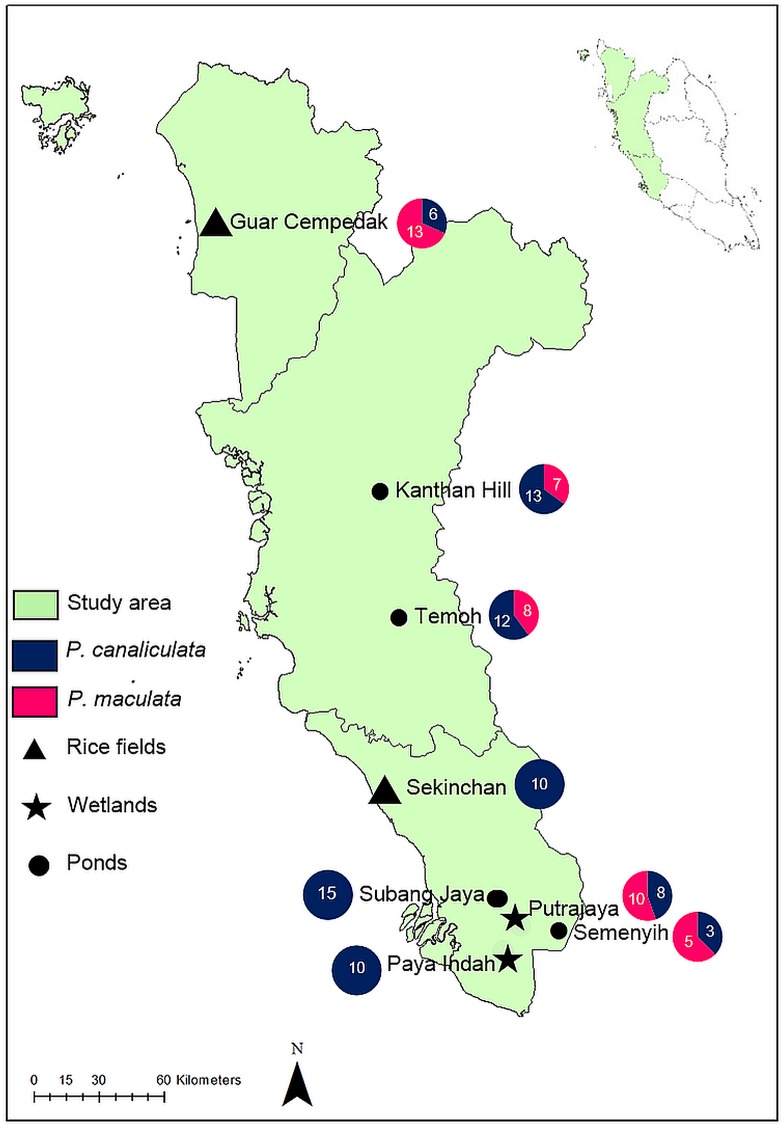
Geographic locations in Peninsular Malaysia where Pomacea specimens were collected February 2016—November 2016.Three to five sites at each location were surveyed to collect 10 to 15 of the largest snails. P. canaliculata occurred at all sites, including Semenyih, Kanthan Hill, and Guar Cempedak, but not P. maculata. Pie charts display prevalence of each species in the sample after genetic screening. Symbols represent habitats.